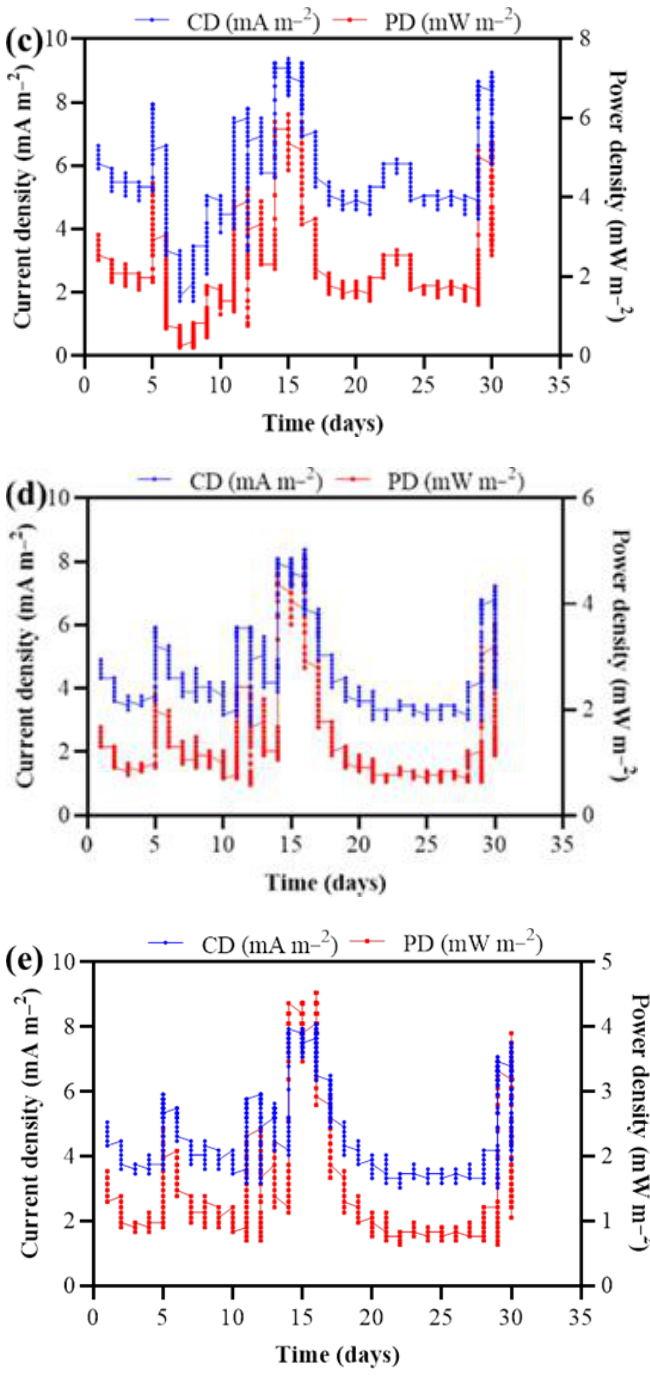
Figure 4. Current – density and power – density curves in ( a ) P-MFC-2, ( b ) P-MFC-1*, ( c ) P-MFC-3, Figure 4. Current–density and power–density curves in ( a ) P-MFC-2, ( b ) P-MFC-1*, ( c ) P-MFC-3, ( d ) P-MFC-4, and ( e ) control reactors for 30 days. Note: CD — current – density; PD — power – density. ( d ) P-MFC-4, and ( e ) control reactors for 30 days. Note: CD—current–density;